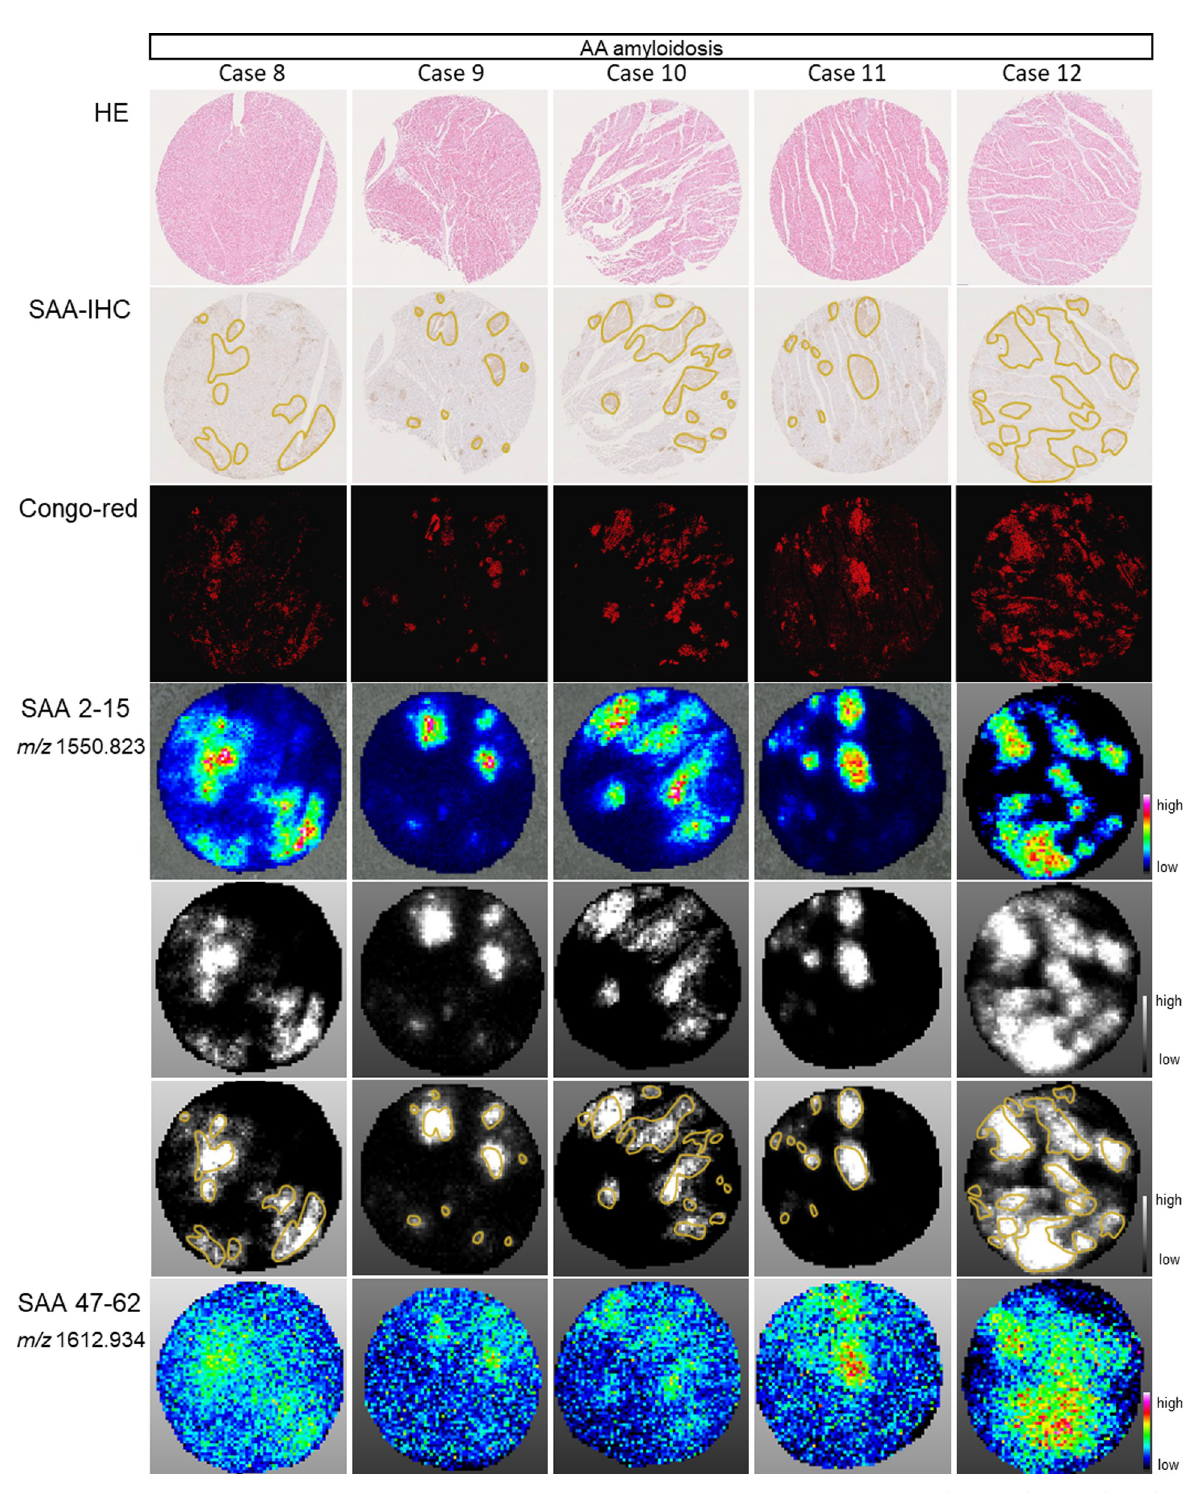
Fig 3. SAA 2–15 specifically localized to amyloid deposits in validation cohort from different institutions. From the upper, hematoxylin and eosin (H&E) staining, immunohistochemistry (IHC) of serum amyloid A (SAA), Congo red staining, and ion images acquired by MALDI-IMS using the second data set were superimposed by tracing of Congo red-positive regions, as needed. SAA 2–15 positivity was observed in Congo red- positive region in five cases with AA amyloidosis. In contrast, the signal of SAA 47–62 was weak and widely scattered in the surrounding area of Congo red-positive region. The core diameter of the histologic section was 3